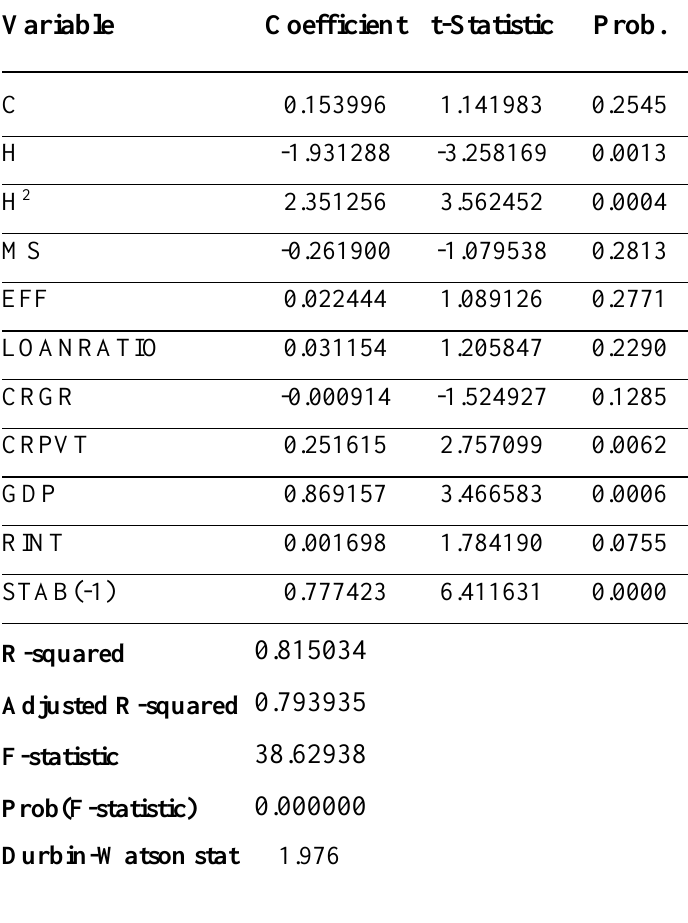
Table 3: Regression Results of the Stability Model-initial estimation